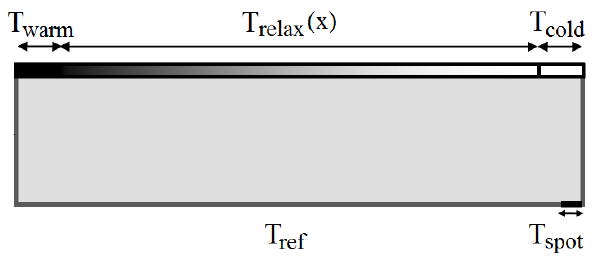
Fig. 1. The schematic drawing of the setup, with the domains where the different values of T relax were applied along the